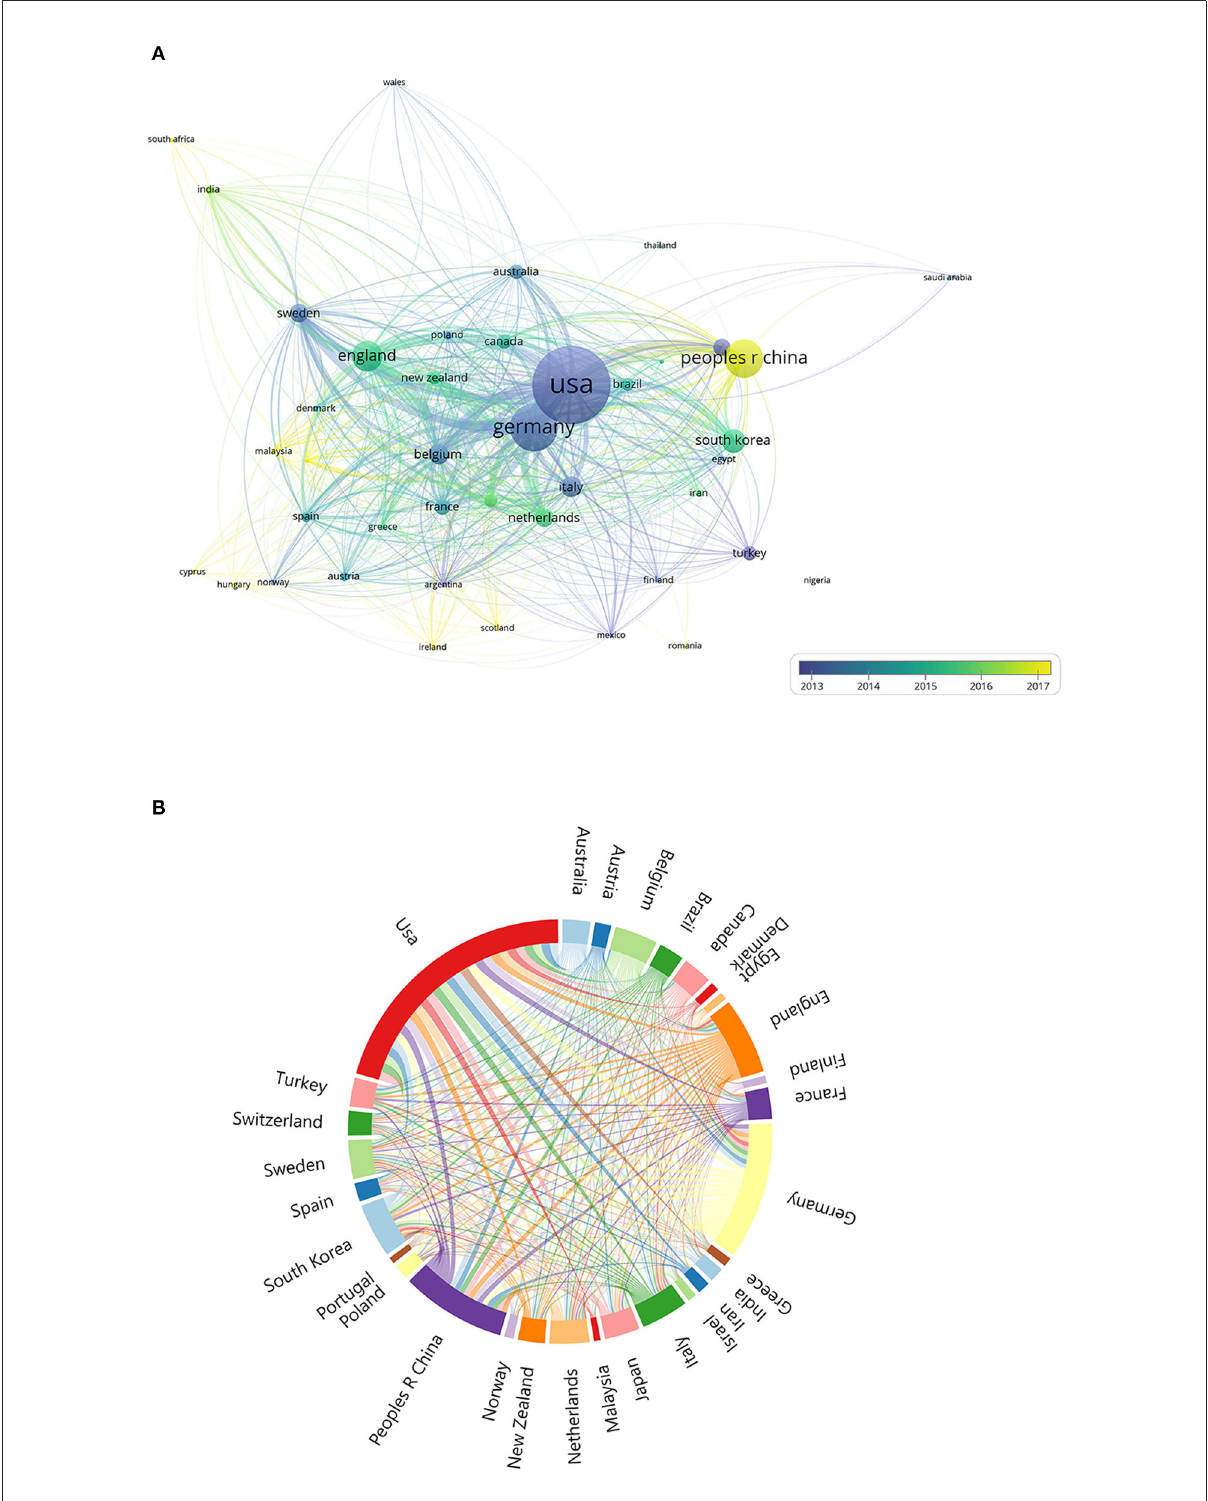
FIGURE3 (A) The font size of each country/regions name represents the number of articles in the country/region. The thickness of the curved connecting line represents the collaborative intensity between countries/region; the country collaboration network of research on tinnitus treatment; different colors inside the circle represent different time intervals. (B) A chord chart of national collaboration. The thickness of the curved connecting line represents the collaborative intensity between